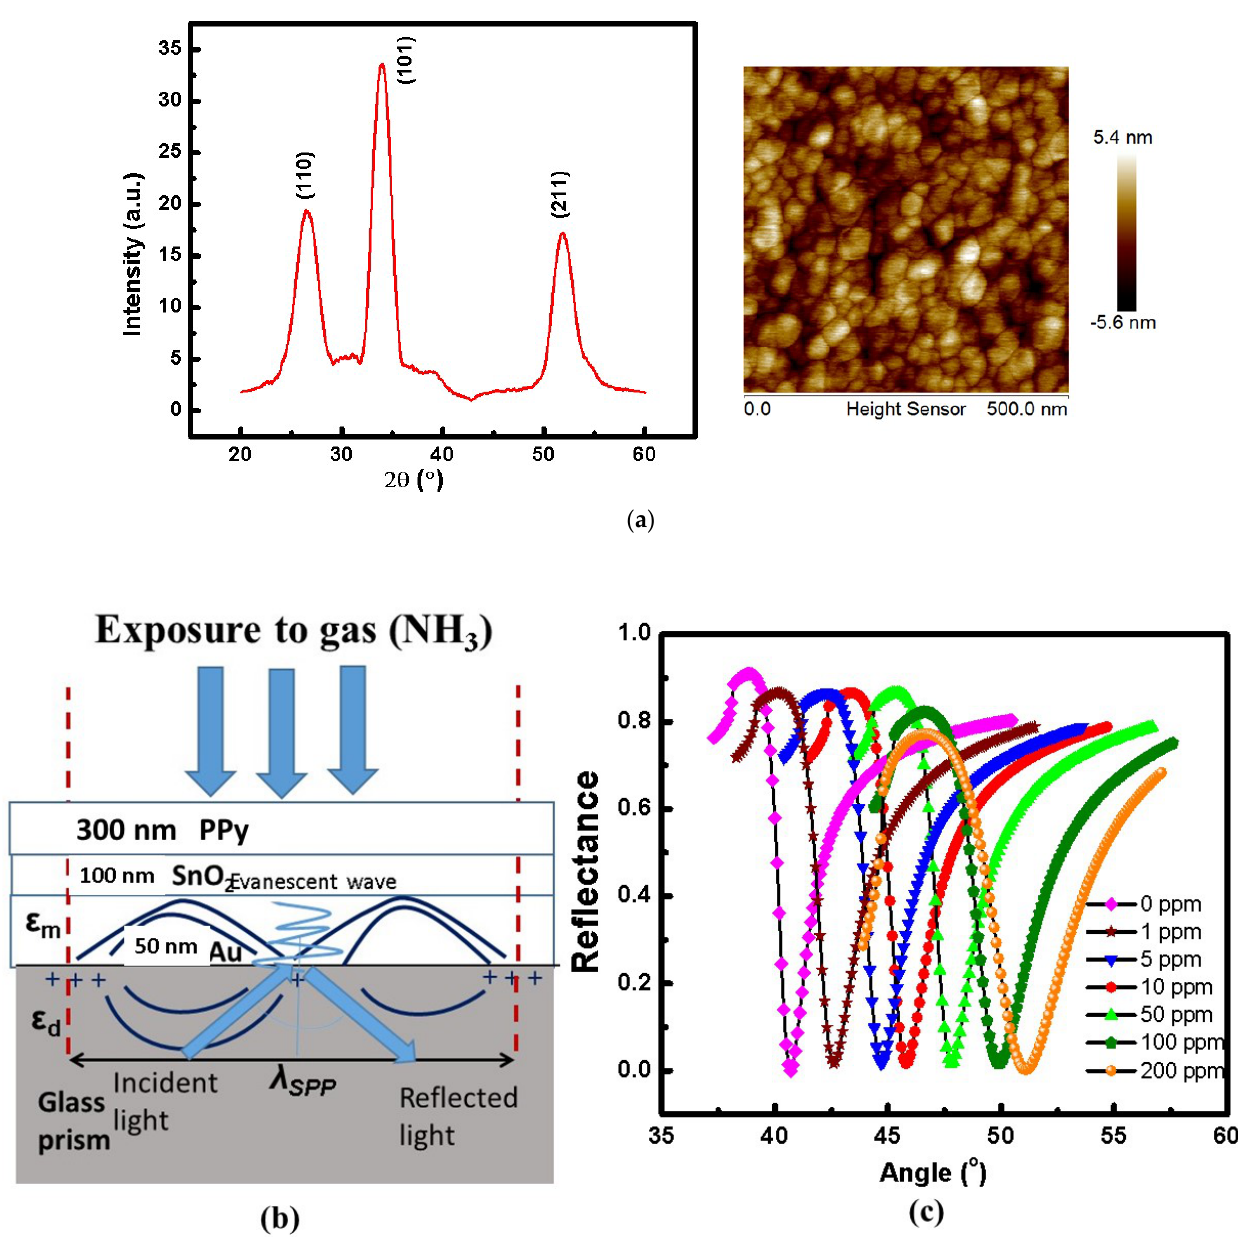
Figure 4. ( a ) Characterisation studies of SnO 2 /PPy nanocomposite thin film including XRD and AFM studies, ( b ) Schematic of the gas sensor system, ( c ) SPR reflectance measurements were made for the (prism + Au + SnO 2 + PPy + NH 3 ) Multi-layered structure after exposure to NH 3 gas at various concentrations.